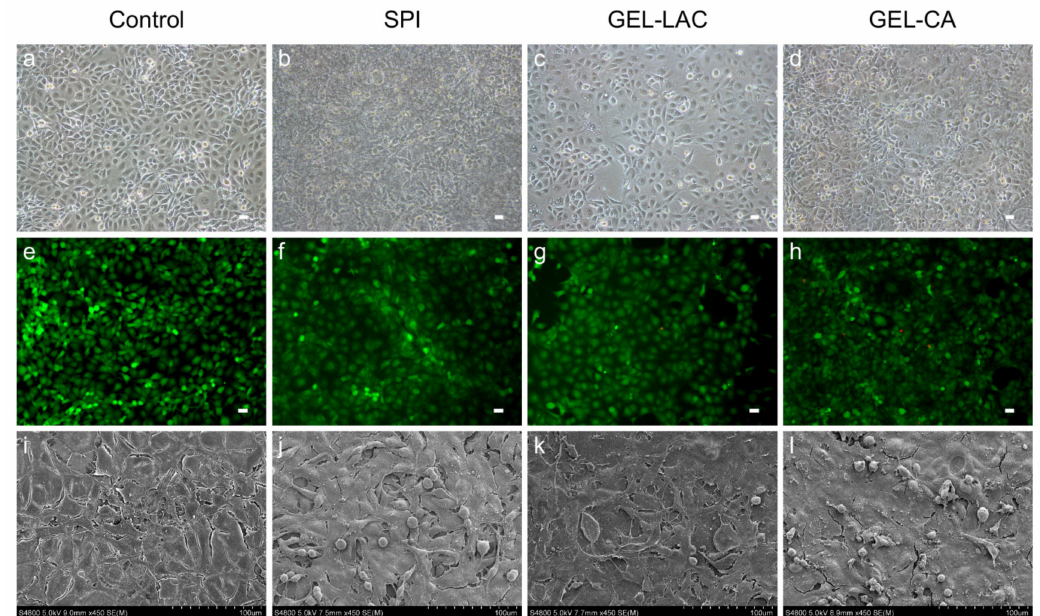
Figure 7. Culture of HCE cells above the films. ( a – d ) Contrast phase microscopic images of HCE cells on tissue culture well plate (control) and the films after 24 h of cell seeding; ( e – h ) representative CA-EthD1 assay images and ( i – l ) SEM images. ( a – h ) Images taken with 10 × magnification; scale bars correspond to 25 µ m. ( i – l ) Images taken with 450 ×